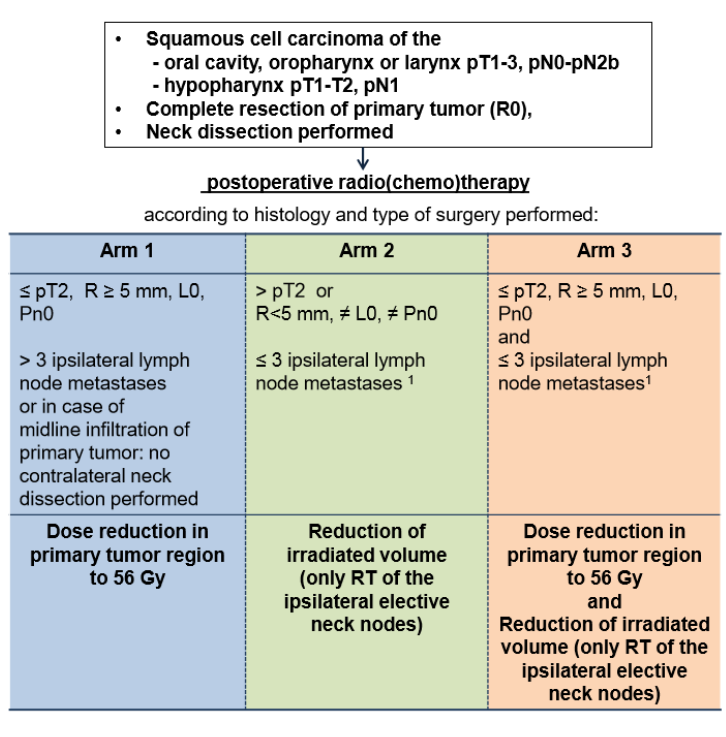
Figure 1. Flow Chart of the DIREKHT trial.